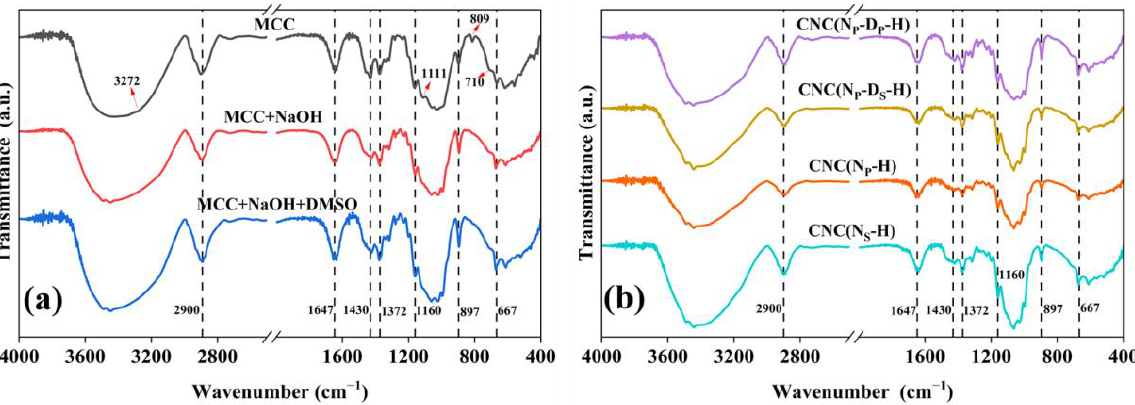
Figure 2. ( a ) FTIR spectra of MCC, MCC after alkaline treatment, and MCC after alkaline treatment and swelling treatment; ( b ) FTIR spectra of CNC samples prepared through different pretreatment routes.